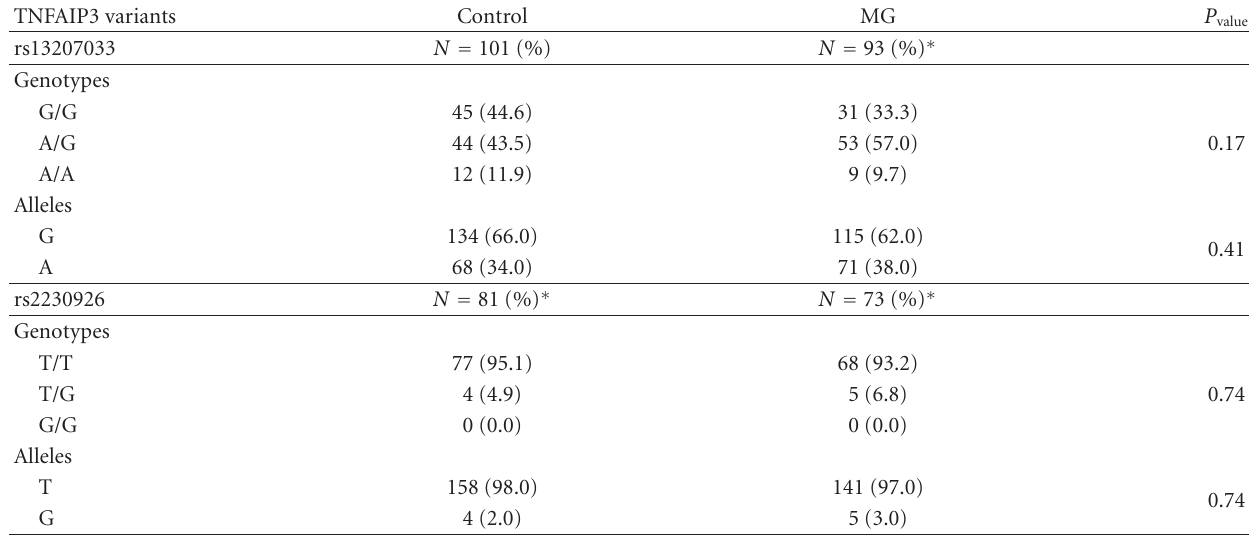
Table 3: TNFAIP3 genotype and allele frequencies in MG patients and controls. Statistical values calculated by χ 2 test are also shown. TNFAIP3